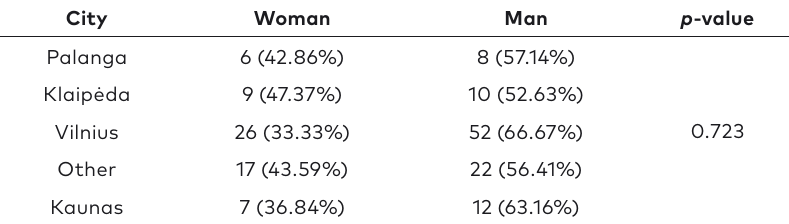
Table 4. The gender distribution of injuries by city in 2019–2020 City